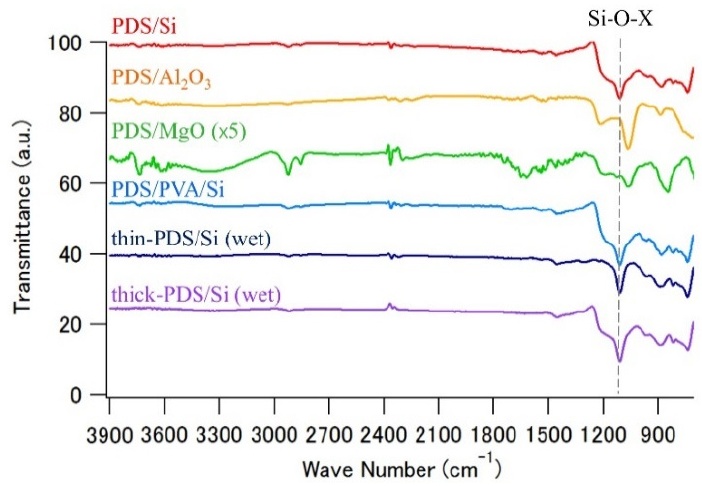
Figure 2. Fourier ‐ transform infrared spectroscopy (FT ‐ IR) attenuated total reflectance (ATR) spectra Figure 2. Fourier-transform infrared spectroscopy (FT-IR) attenuated total reflectance (ATR) spectra (mean) of the thin PHPS ‐ derived silica (PDS) layer samples. The vertical axis scale of PDS/MgO data (mean) of the thin PHPS-derived silica (PDS) layer samples. The vertical axis scale of PDS/MgO data was enlarged to five times its original size. was enlarged to five times its original